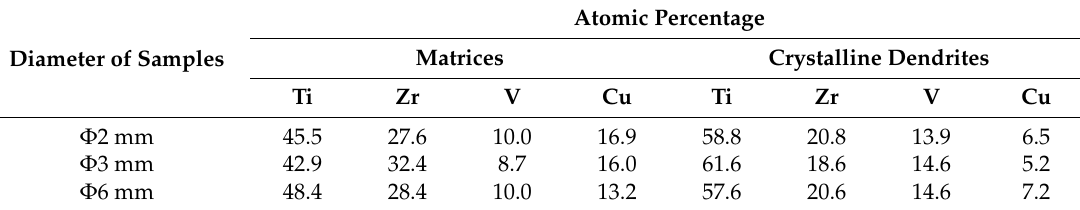
Atomic Percentage